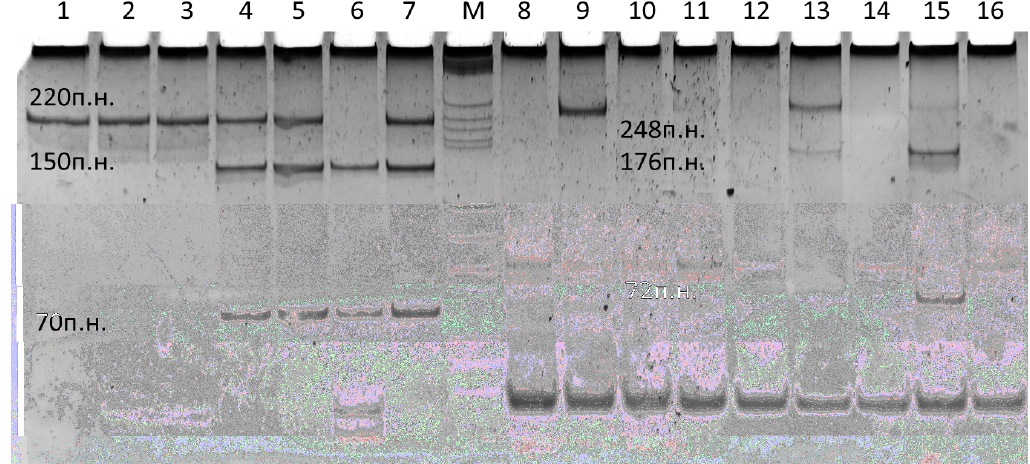
Fig. 1. Electrophoresis in 8% polyacrylamide gel of MC4R and Leptin(LEP) gene restrictions. Lane: 1-3 AA genotype, lane: 4, 5, 7 AG genotype, lane: 6 GG genotype, MC4R gene. Lane: 8, 10, 11, 12, 14, 15, 16 genotype TT, lane: 9 genotype AA,